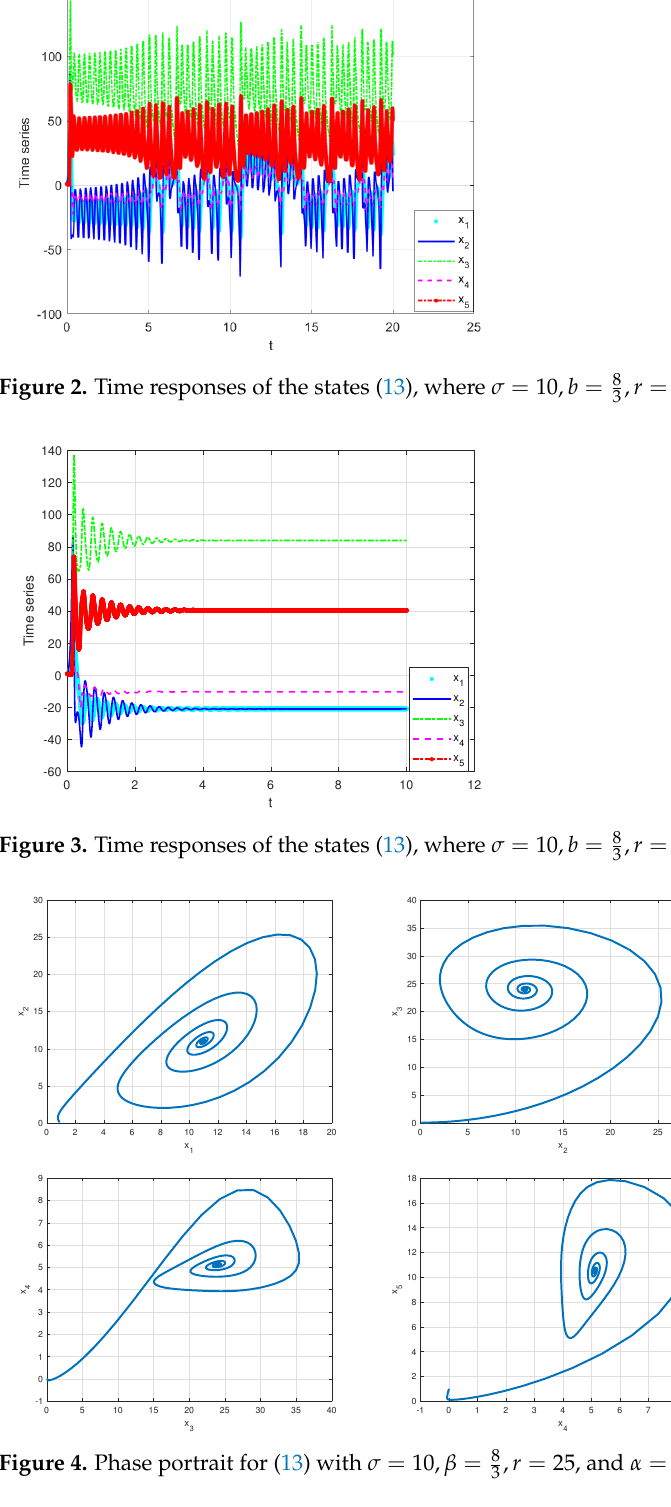
Figure 4. Phase portrait for (13) with σ = 10, β = 8